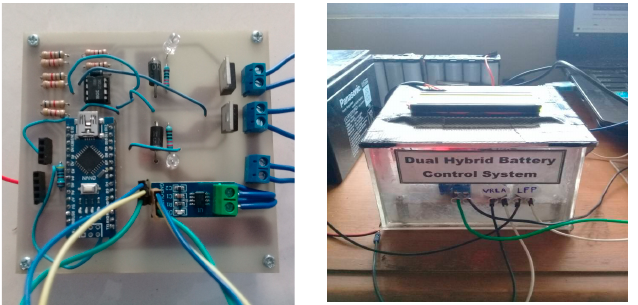
Figure 11. Dual battery control system.